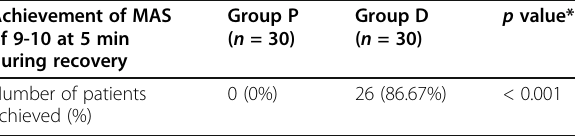
Table 4 Modified Aldrete score (MAS) of 9-10 at 5 min during recovery